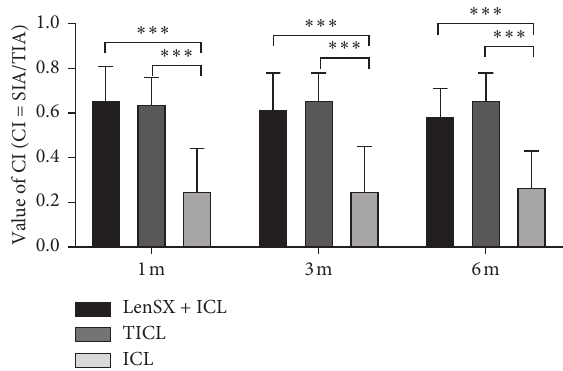
Figure 7: The comparison in astigmatism correction index among the three groups after surgery at 1, 3, and 6 months (the results are expressed as the means ± SD, ∗∗∗ P < 0 .